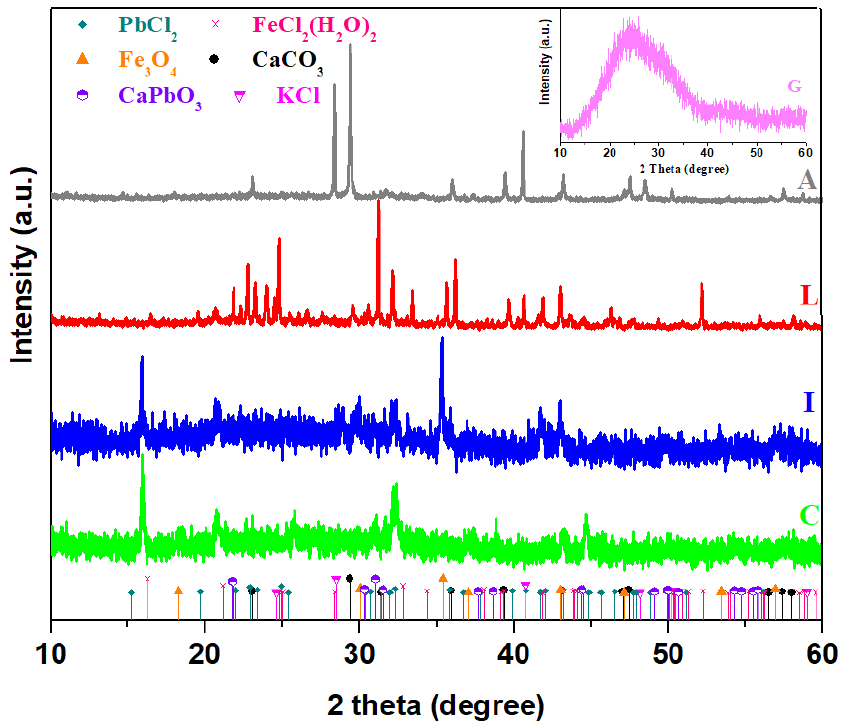
Figure 1. X ‐ ray patterns of the broken glasses (G) and prepared composite materials (C—mixture of glasses and cash iron, I—mixture of glasses and iron powder, L—mixtureof glasses and lead powder, A—mixture of glasses and ash).